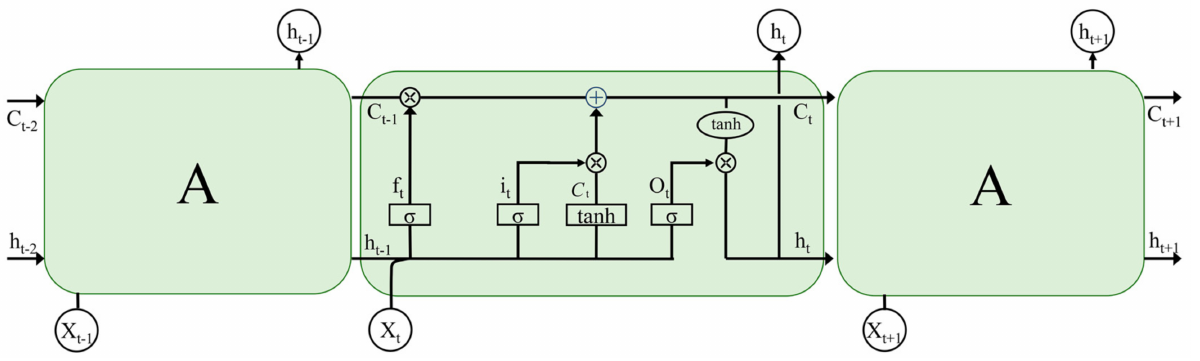
Figure 3. LSTM memory cell unit structure